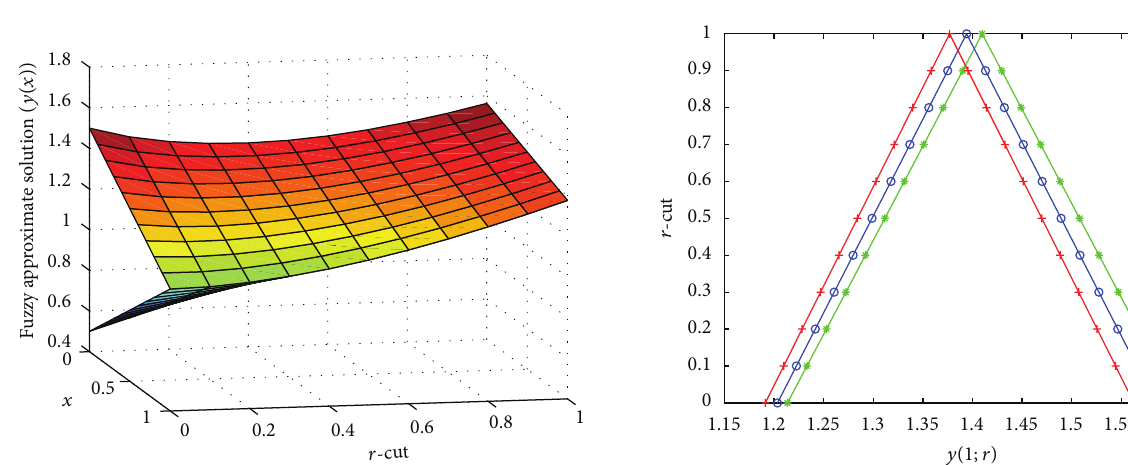
Figure 7: The fuzzy approximate solution of Example 57, 𝛼 = 0.95, 𝑚 = 6 .